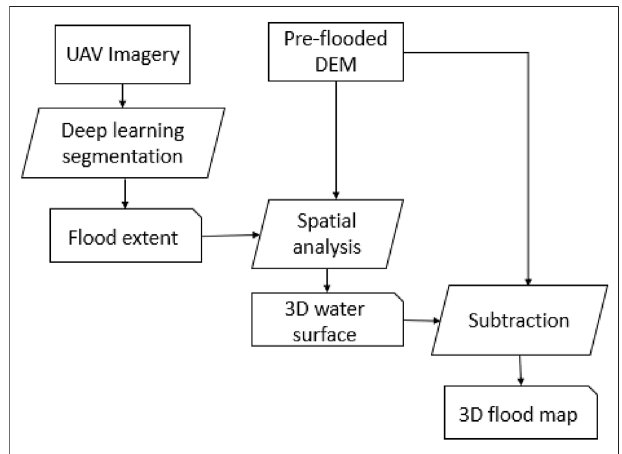
FIGURE 1 | Inundation depth estimation using deep learning image classi fi cation and